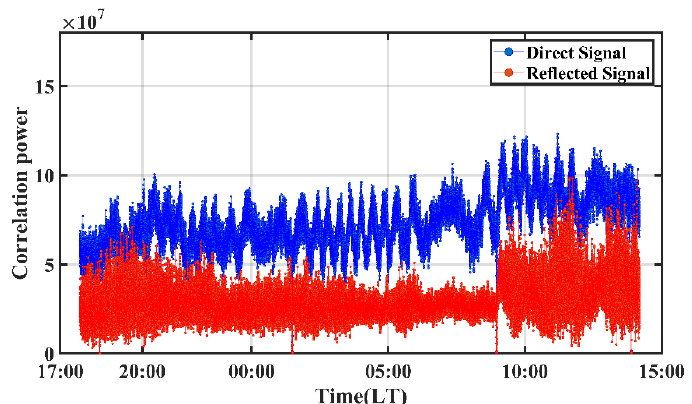
Figure 10. The power of the direct signals (blue) and the reflected signals (red).